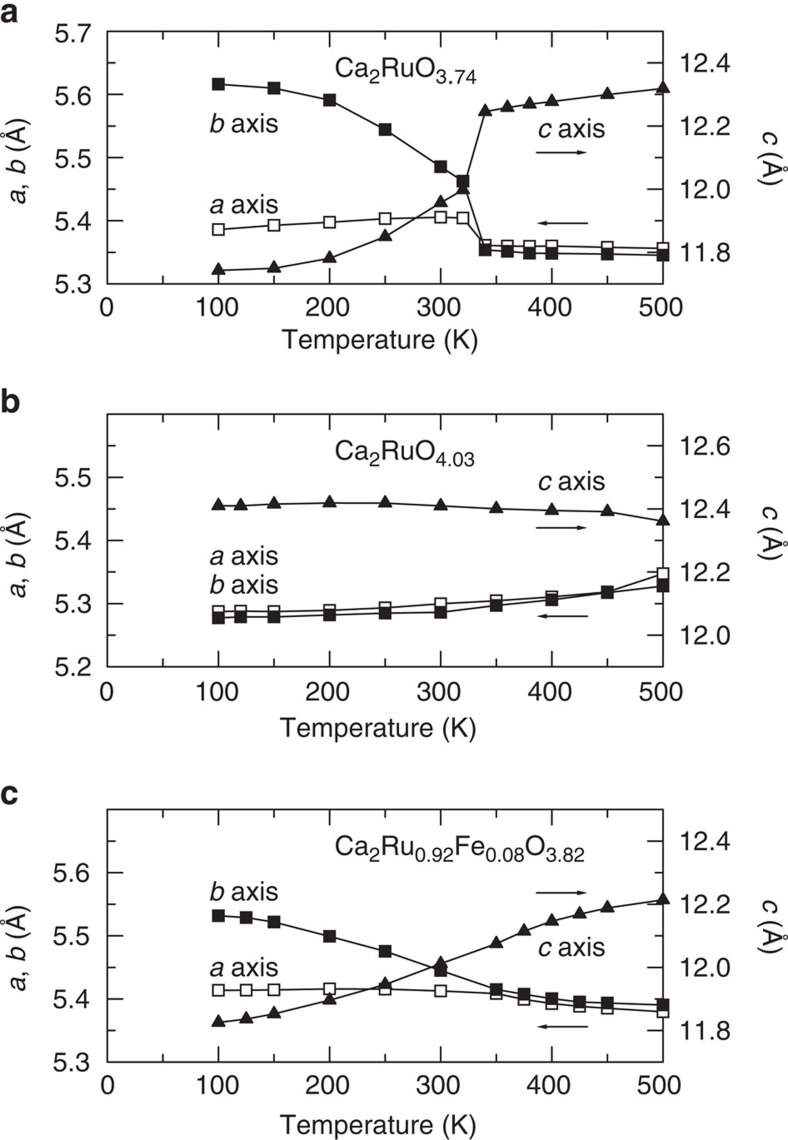
Temperature dependence of the lattice parameters.(a) Ca2RuO3.74, (b) Ca2RuO4.03 and (c) Ca2Ru0.92Fe0.08O3.82. These values are estimated based on Le Bail analysis of the XRD data. For Ca2RuO3.74, the c axis decreases abruptly below TMI=345 K. The S phase is characterized by highly anisotropic thermal expansion. The a and b axes increase, although the c axis decreases concomitantly with decreasing temperature. The present results confirmed that the negative thermal expansion appears in the S phase.